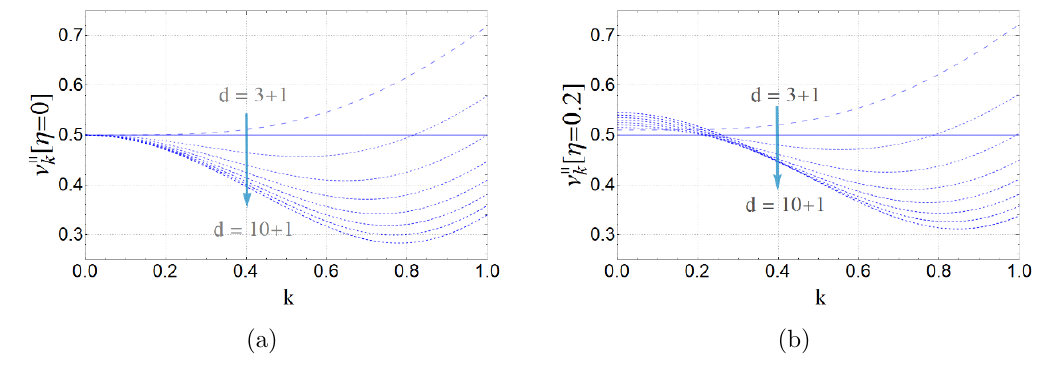
Figure 7. Left: for (cid:17) = 0 and d > 4 low energy spectral weight is present in the form of a smeared Fermi surface. For d = 4 there is no spectral weight. Right: increasing (cid:17) immediately lifts the smeared Fermi surface to a Fermi shell, as in (cid:12)gure 6(b) above.